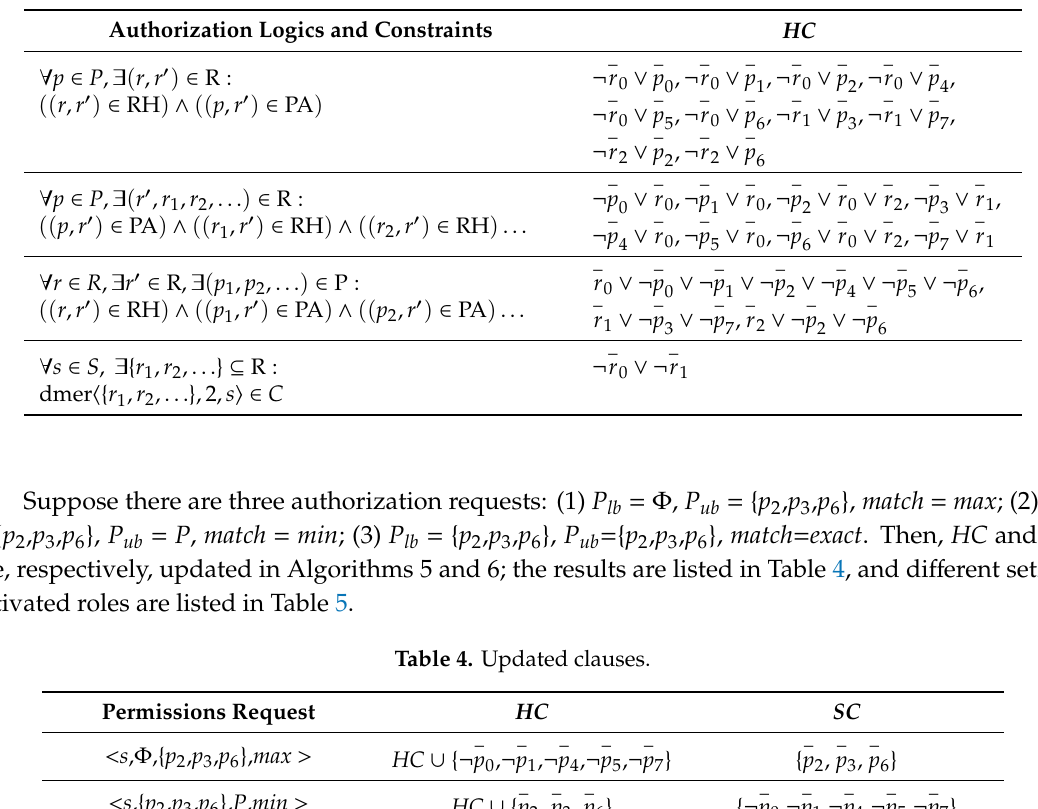
Table 3. Hard clauses.